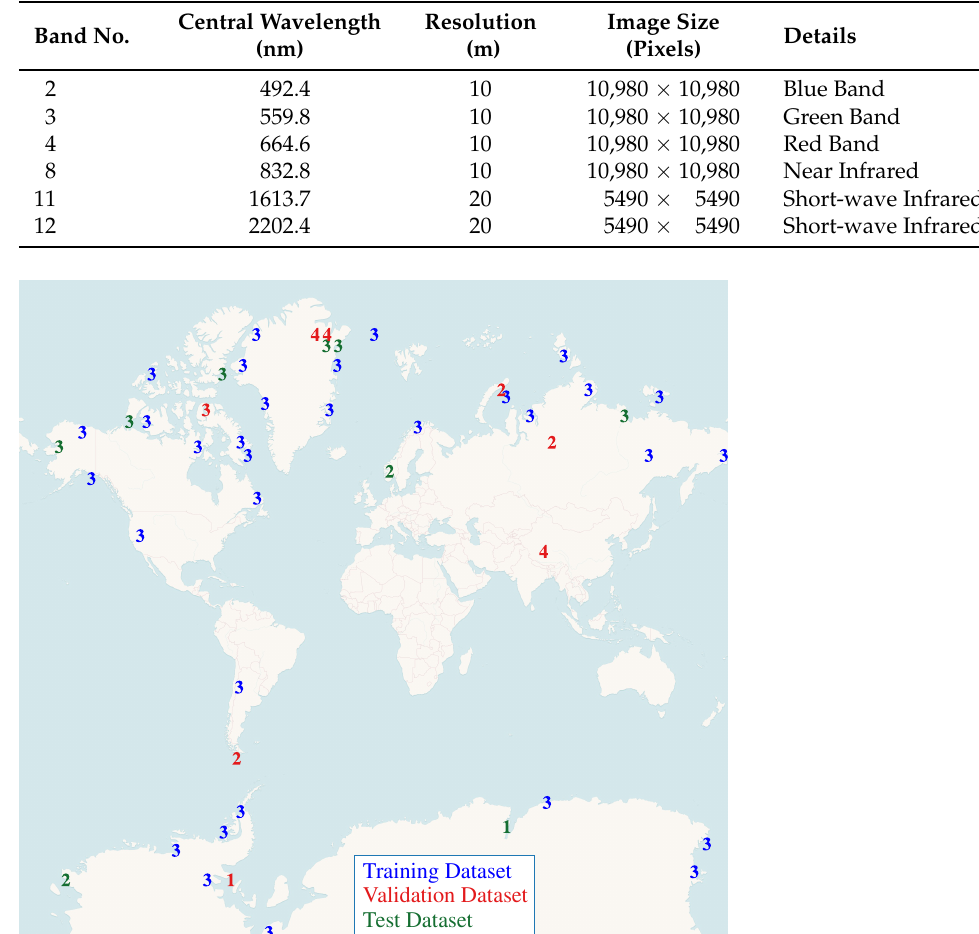
manually using the QGIS software [41] package. In addition to the true color image, the short-wave infrared band (B11) and the near infrared band (B08) were used in our labeling process. Labeling of very small targets was performed occasionally using a thresholding operation in the local neighborhood of the